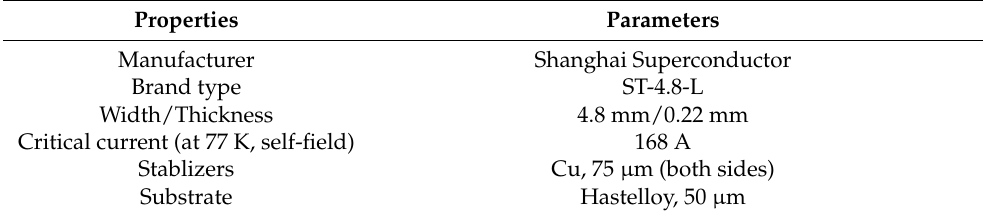
Table 1. HTS tape